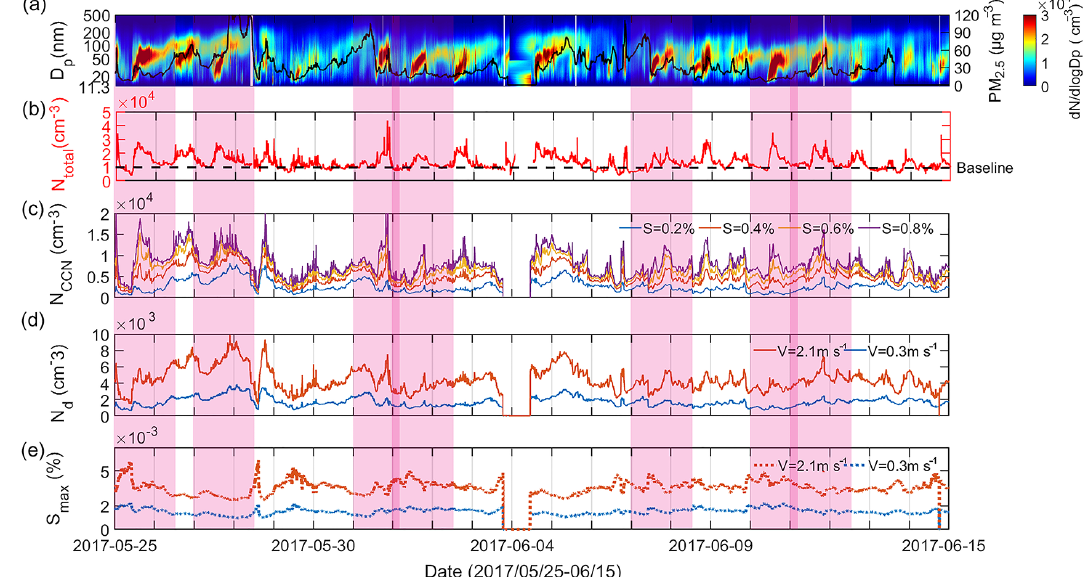
Figure 2. Time series of (a) particle number size distribution (PNSD) (the selected seven typical NPF events are marked by pink shading), (b) the total particle number concentration ( N total ), (c) CCN number concentration ( N CCN ), (d) cloud droplet number concentration ( N d ) and (e) the maximum supersaturation ( S max ) from 25 May to 15 June